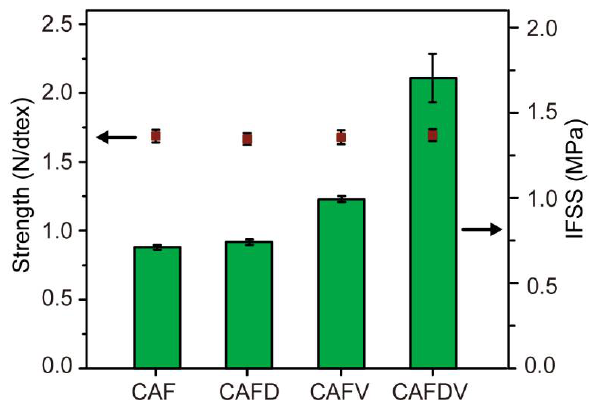
Figure 7. Mechanical strength and IFSS of the CAF.